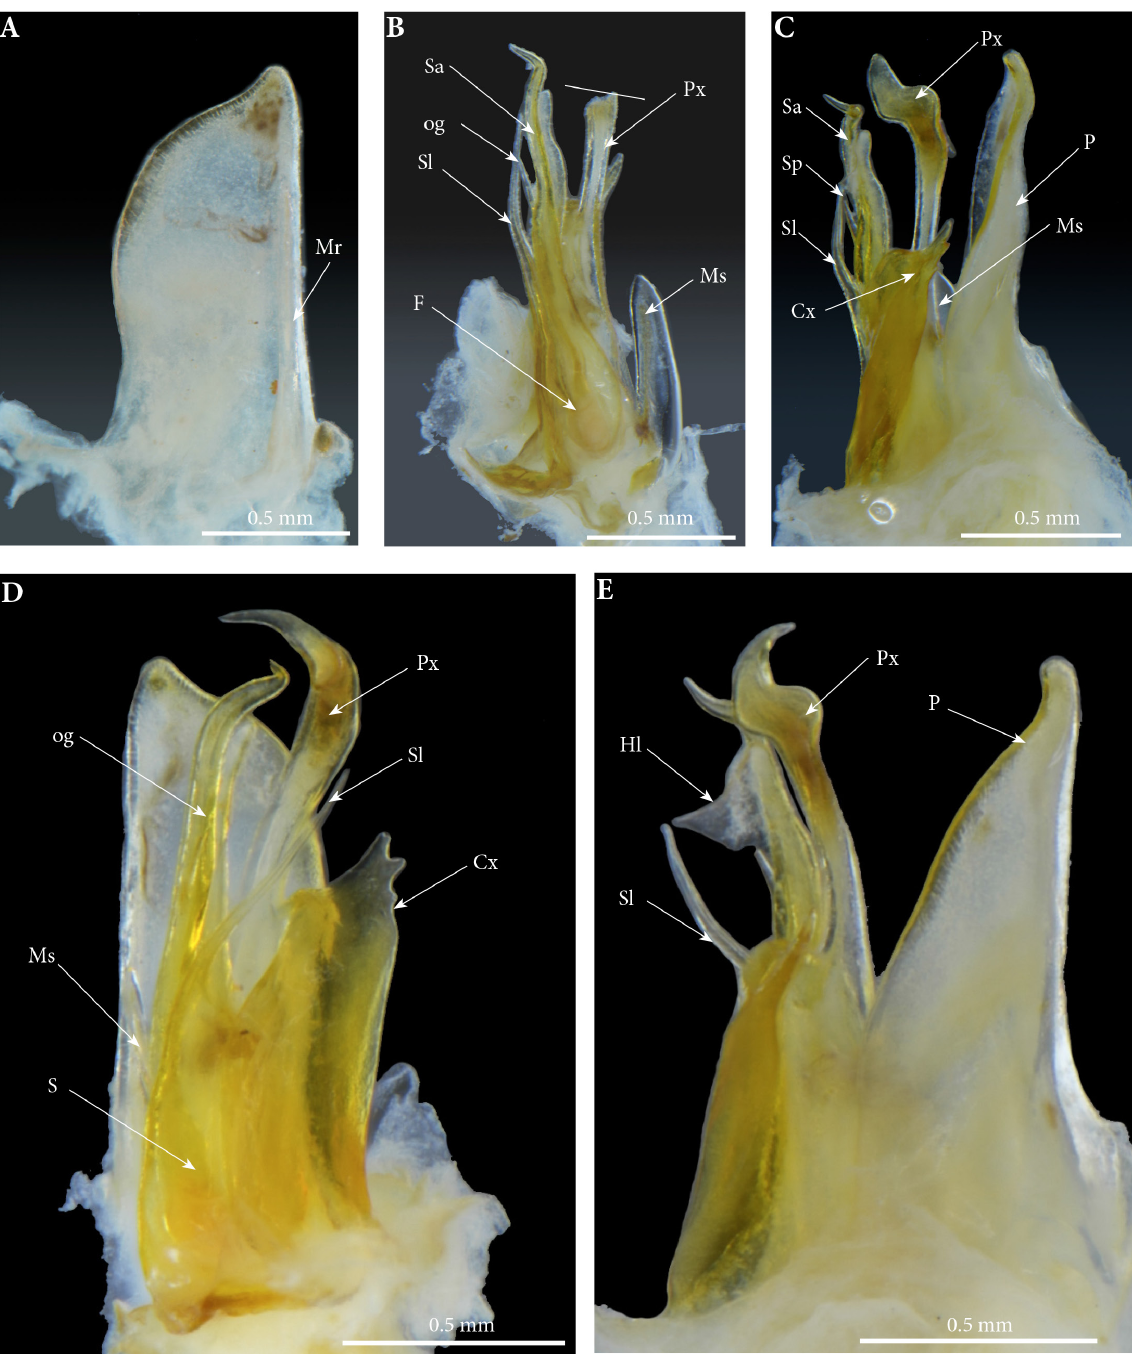
Fig. 2. Ommatoiulus alacygni sp. nov. Holotype ♂, gonopods. A . Right promerite, posterior view. B . Right posterior gonopod, mesal view. Line marking the broken paracoxite. C . Left gonopod, lateral view. D . Left gonopod, meso-posterior gonopod. E . Left gonopod, antero-lateral